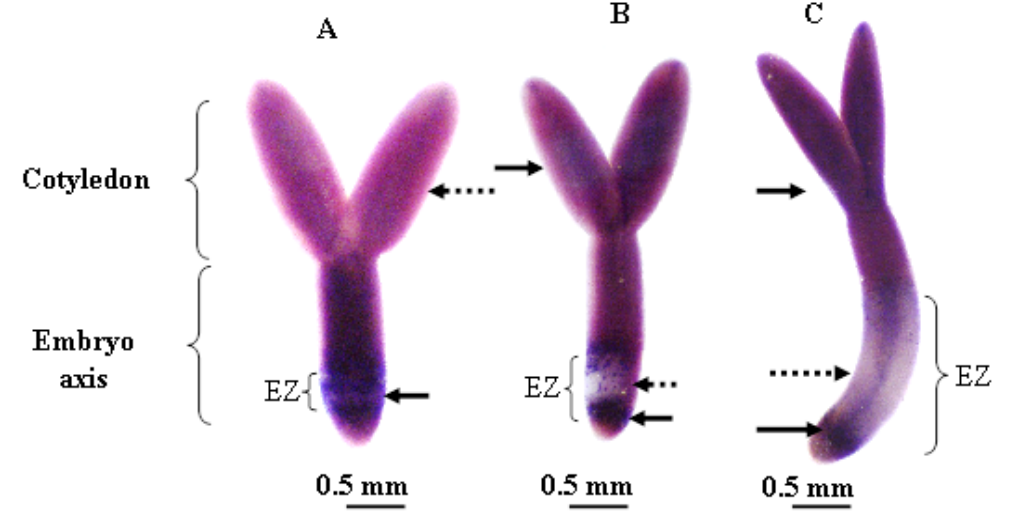
Fig. 4. Histochemical localization of the NBT reduction in embryos isolated from (A) salt imbibed seeds, (B) H bibed seeds, and (C) seeds germinating in distilled water. The continuous arrows indicate high production of the super- oxide anion radical (O 2·- ) and the discontinuous arrows indicate low production of the superoxide anion radical (O 2·- ). Ez: Elongation